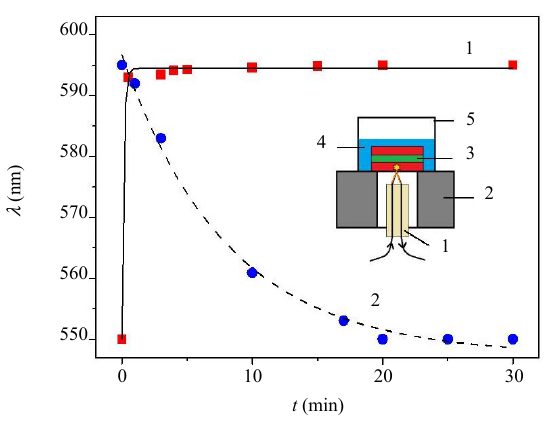
Fig. 2 Time dependencies of the wavelength of the first stop band of AAO PC during impregnation with water-ethanol (42.5 wt. %) mixture (squares) and subsequent drying (circles). The size of the symbols corresponds to the size of error bars. Lines 1 and 2 are given just for eye guide. The measurement scheme (1 – optical fiber probe; 2 – mounting platform; 3 – sample; 4 – analyte; 5 – plastic vessel) is given in inset.